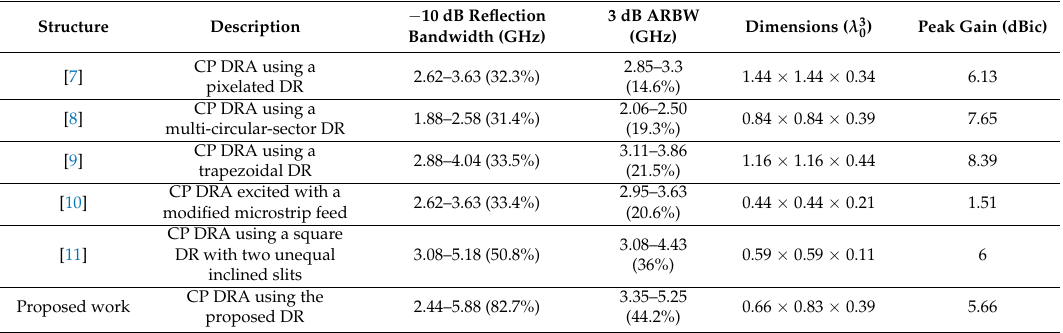
Table 2. Comparison of the proposed work with earlier published work. Note that λ 0 represents the wavelength at the center frequency of the 3 dB ARBW. CP: circularly polarized; DRA: Dielectric resonator